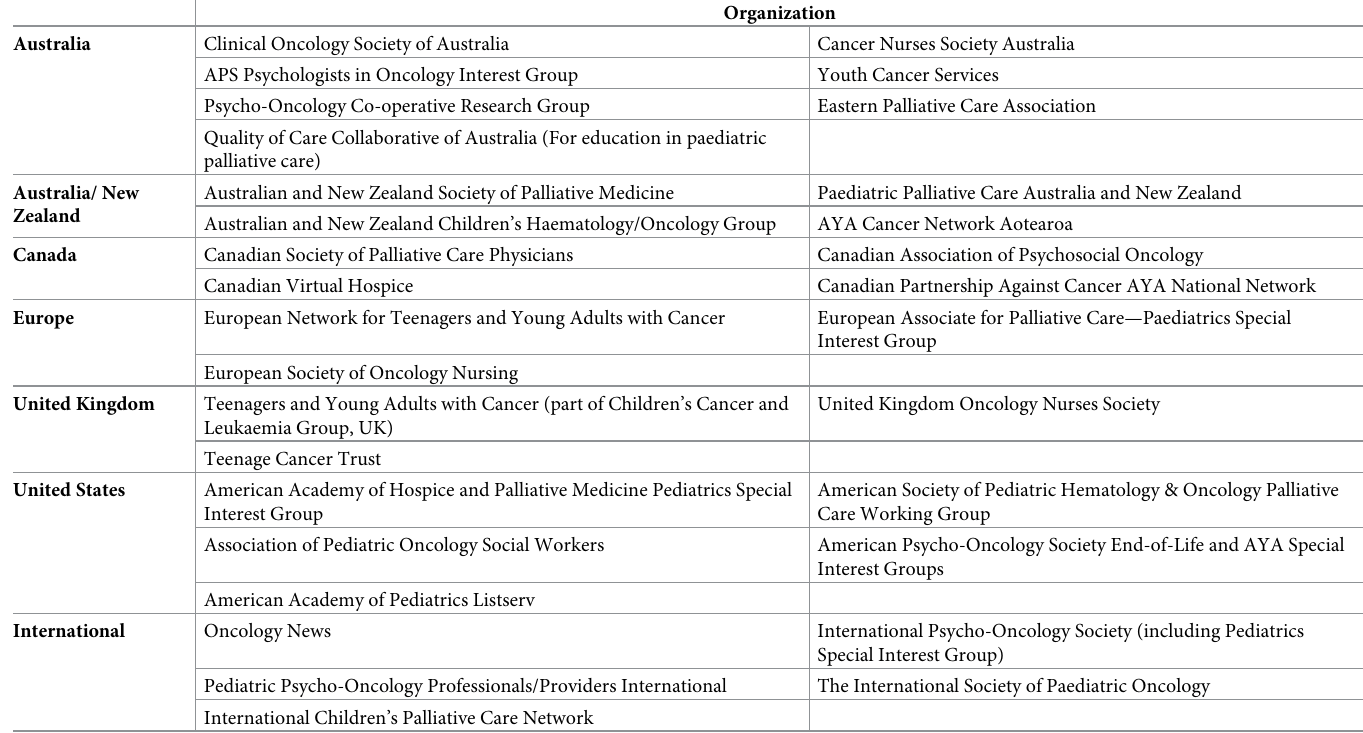
Table 3. List of professional organizations/networks to be used for Round 2 participant